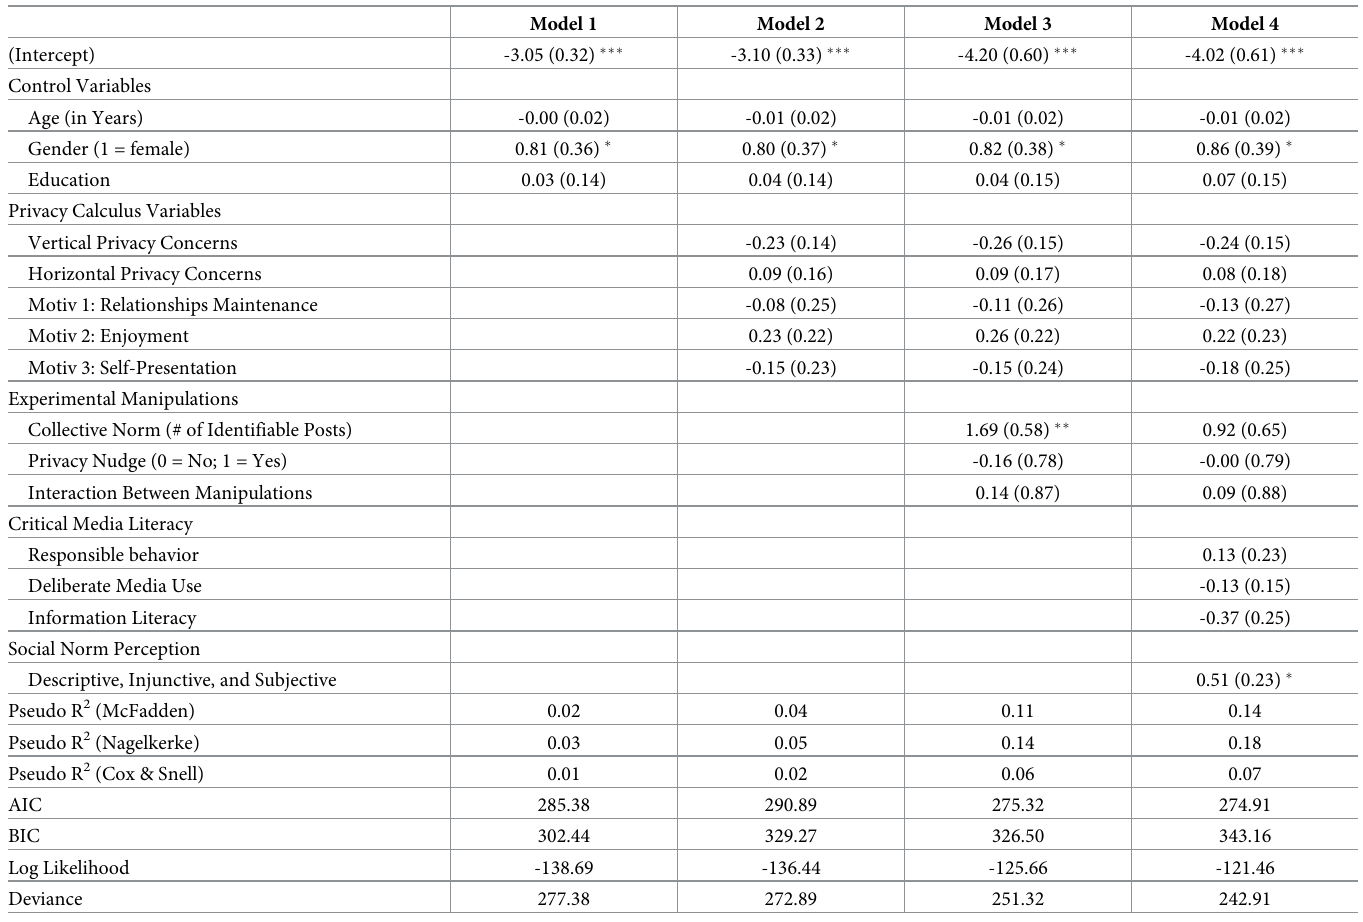
Table 1. Logistic regression model predicting visual disclosure (Study